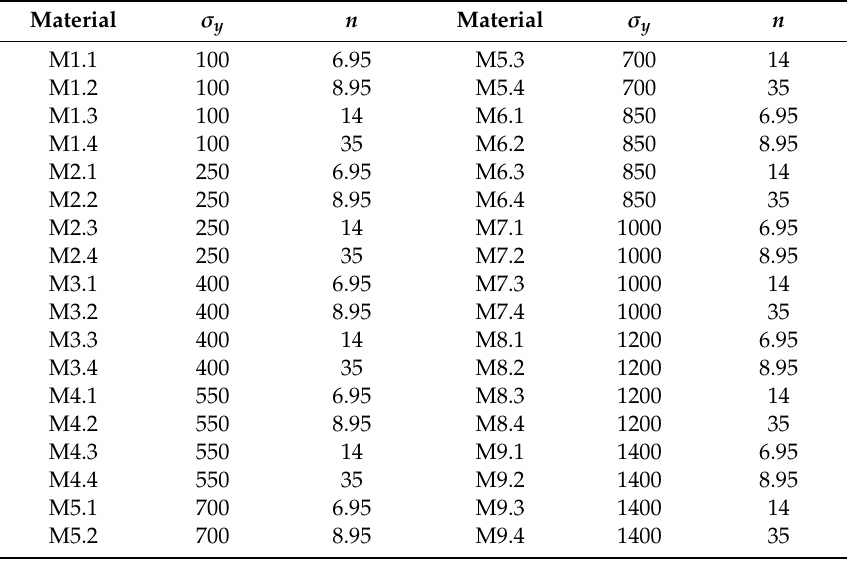
Table 1. Plastic parameters of hypothetical